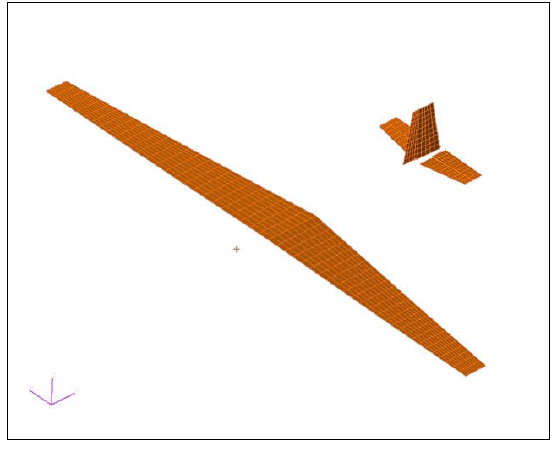
Fig 4. Aerodynamic